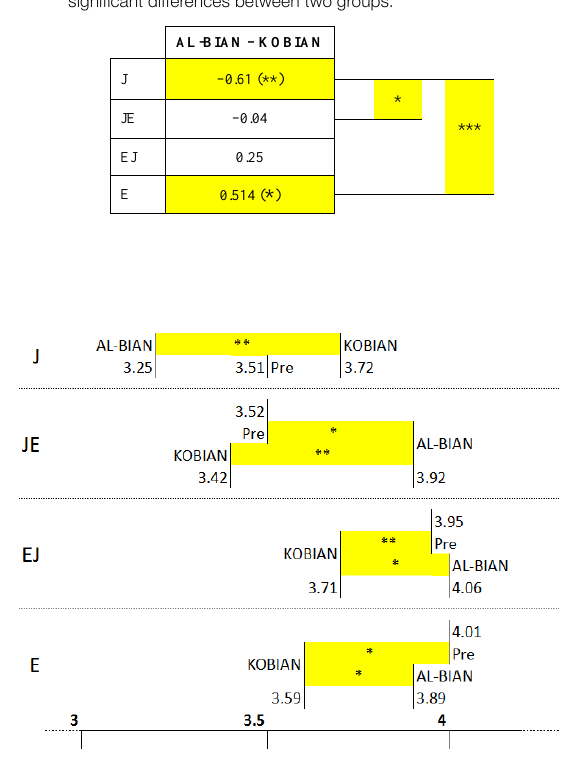
Figure 6. Zoom in variations of Likeability on 1 to 5 scale. In yellow, statisti- cally significant differences: one asterisk (*) means p <.05; two as- terisks (**) mean p <.01; three asterisks mean p <.001. J, E, EJ and JE indicate the groups described in section 3.1. “Pre” indicates the preliminary assessment on Humanoid robots done before doing the